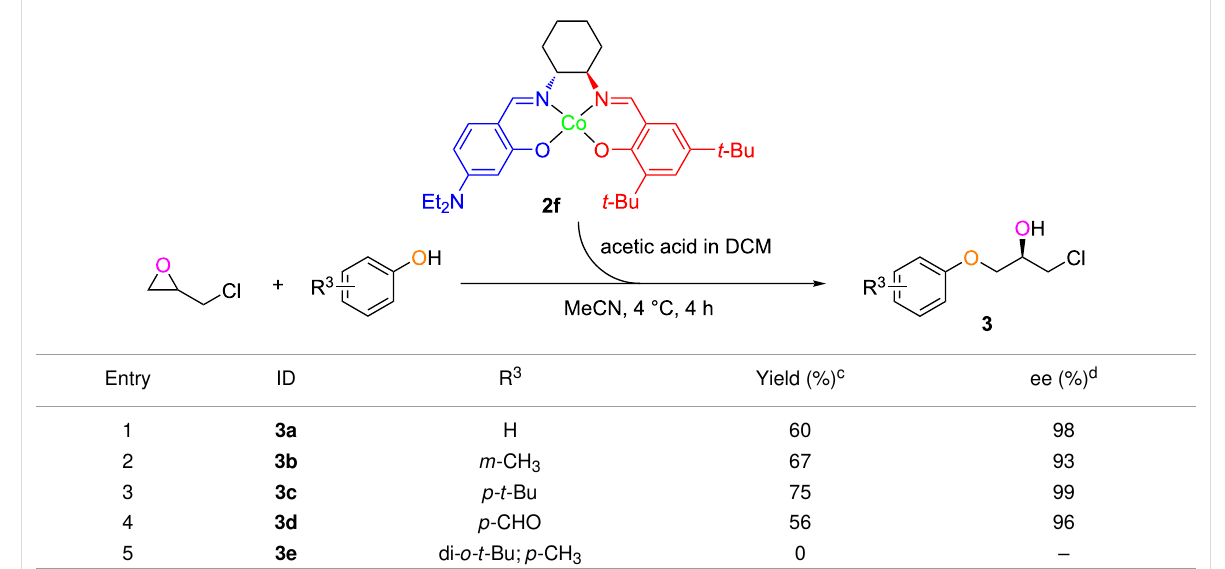
Table 3: Synthesis of α -aryloxy alcohols 3 by KR of epichlorohydrin with phenols catalyzed by complex 2f . a,b